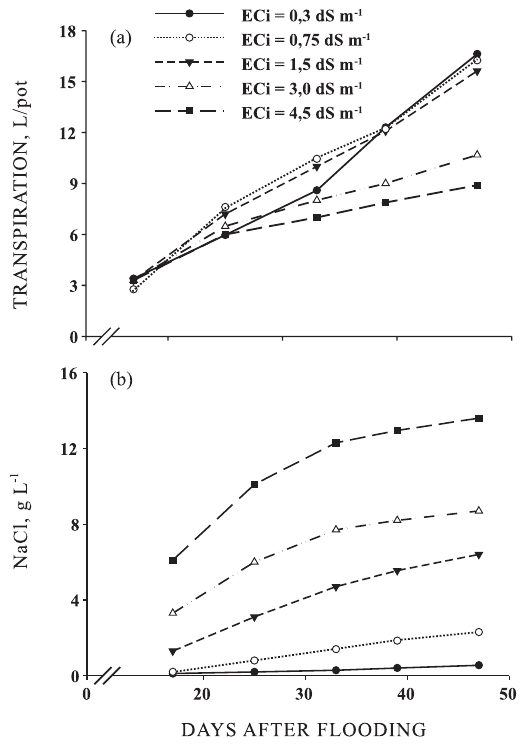
Figura 2. Amount of water transpired (a) and amount of sodium supplied in the transpiration flow (b) throughout rice development, according to the electrical conductivity of the water layer (ECi).